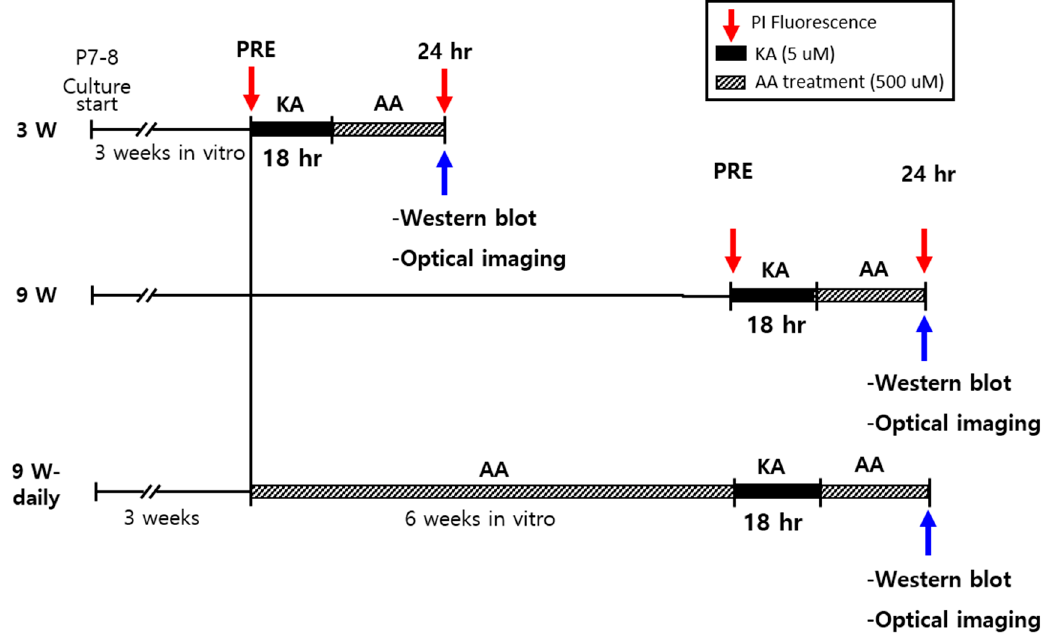
Figure 1. Experimental design and paradigm. Organotypic hippocampal slice cultures (OHSCs) were cultured for 3 w and 9 w. Slices were treated with propidium iodide (PI) 2 h before 5 µM kinetic acid (KA) treatment for all cultures (PRE). All received KA treatment except for the normal controls in each experimental group. After 18 h exposure to KA, the medium containing KA was changed to a fresh culture medium containing 500 µM ascorbic acid (AA). PI uptake, Western blot, and electrophysiological studies were conducted 24 h after AA treatment. Experimental groups were divided by culture time and treatment type, such as 3 w, 9 w, and 9 w-daily. In the 9 w-daily group, 500 µM AA was added to the culture medium for 6 w before studies began.